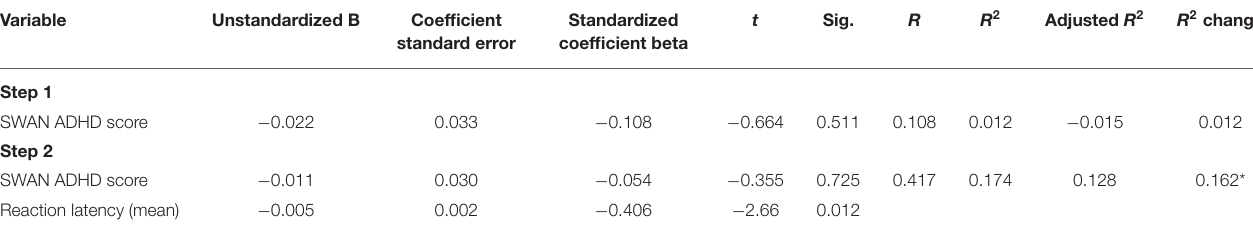
TABLE 12 | Regression model of the AST measures as the predictors of the CBCL social problem subscale score in the SCT group. Variable